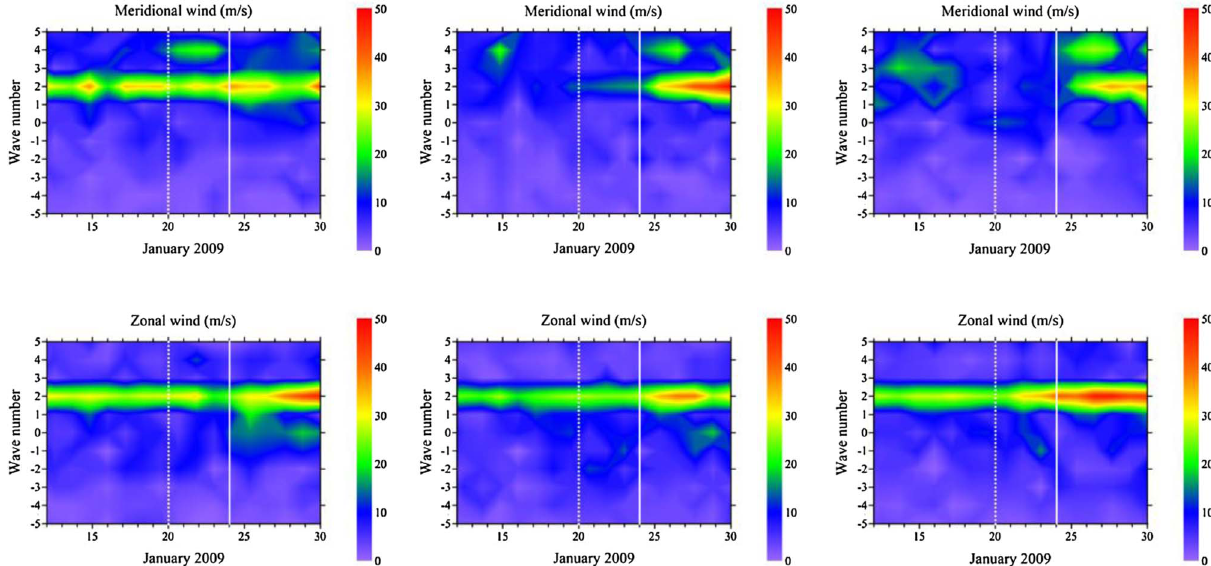
Fig. 8. Spectra of the EAGLE-simulated semidiurnal tidal variations in the meridional (top) and zonal (bottom) components of wind at 20 (cid:3) N (left), equator (middle), and 20 (cid:3) S (right) at 114 km altitude. Vertical lines indicate the onset (dotted) and peak (solid) of the 2009 SSW.